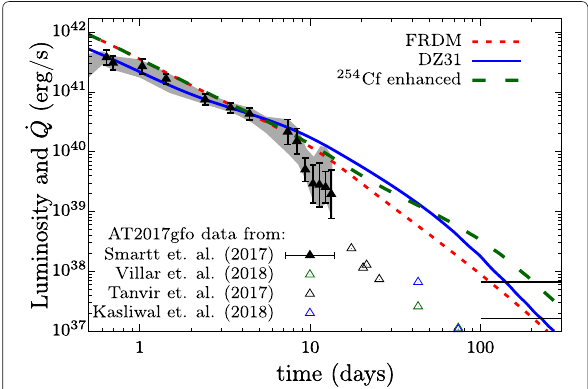
Fig. 4 Impact of the existence of actinides on the bolometric lightcurve of kilonovae. The dotted red, solid blue, and dashed green lines (labeled by FRDM, DZ31, and 254 Cf enhanced) represent cases where the lightcurves are dominated by the energy release from β -decays, α -decay actinides, and spontaneous fission of 254 Cf, normalized to t = 6 days. The filled and the hollow triangles are the observed and the lower bound of the brightness of the GW170817 kilonova. Data for this plot are taken from [62]